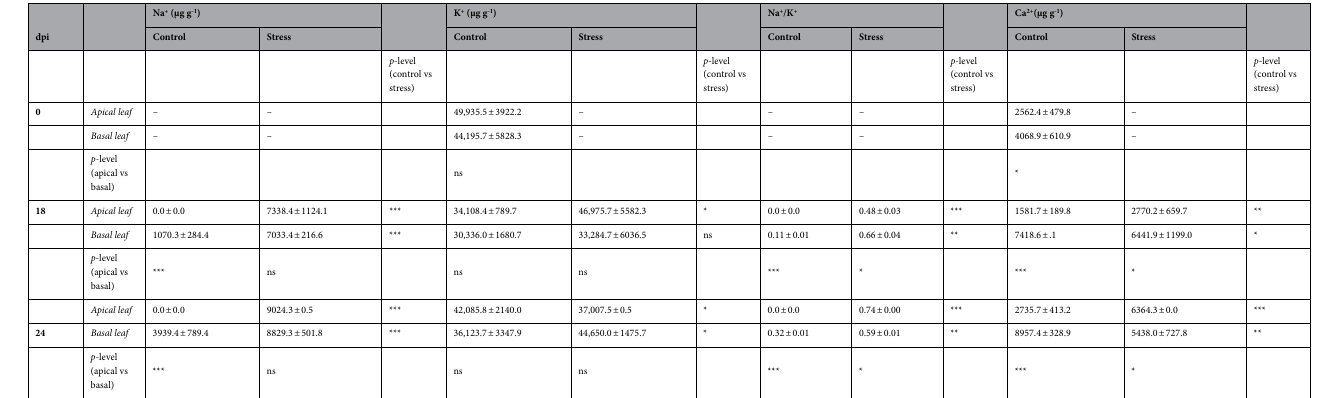
Table 2. Concentration of Na + (µg g −1 ), K + (µg g −1 ) and Ca 2+ (µg g −1 ) in control- and salt stressed. Arundo donax plants were measured at different sampling times: in the initial phase (0 dpi), in the median phase (18 dpi), and in the final phase (24 dpi). Values represent the mean ± standard errors (n = 4). ANOVA was reported to assess statistical differences between control and salt-stressed plants and between apical and basal leaf level (*** p ≤ 0.001; ** p ≤ 0.01; * p ≤ 0.05; ns, not